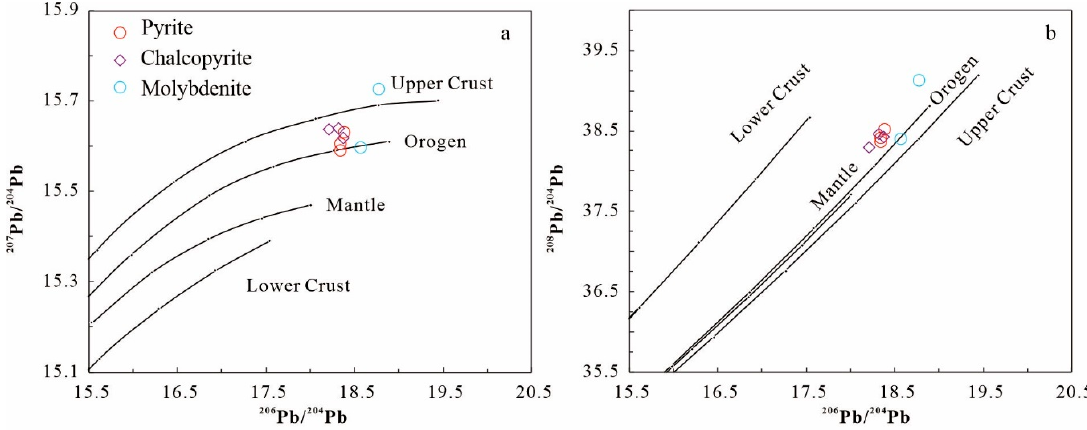
Figure 10. Diagram of lead isotopic compositions of the Reshui Mo deposit. The base map is from Zartman et al. [94]. ( a ) Plots of 207 Pb / 204 Pb vs. 206 Pb / 204 Pb; ( b ) Plots of 208 Pb / 204 Pb vs. 206 Pb / 204